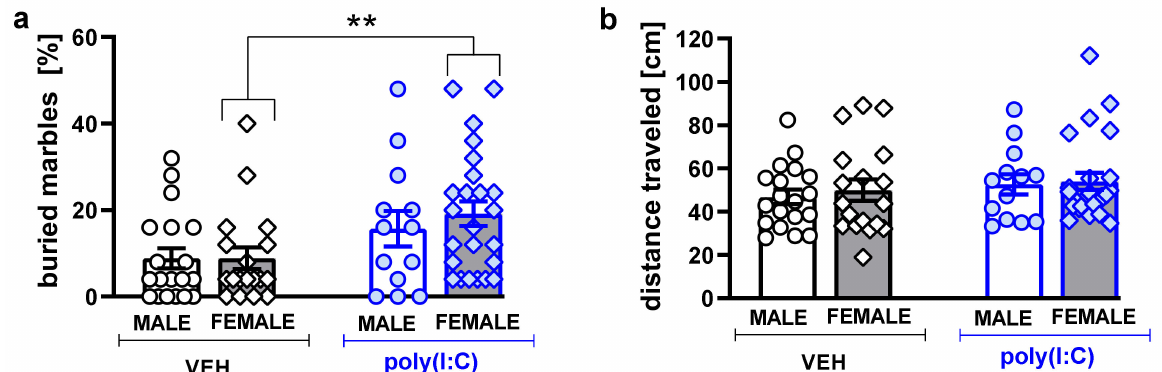
Figure 6. Poly(I:C) exposure increased repetitive-like marble-burying behavior. Data are presented as the percentage of buried marbles ( a ) and distance traveled ( b ). Symbol: ** p < 0.01, a significant difference between vehicle- and poly(I:C)- exposed animals in a given sex group (Mann–Whitney U